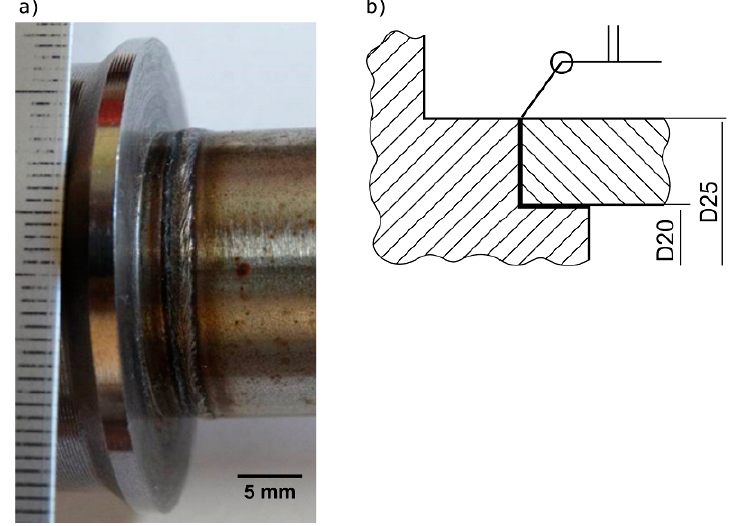
Figure 1. The welded joint: ( a ) general view, ( b ) design.